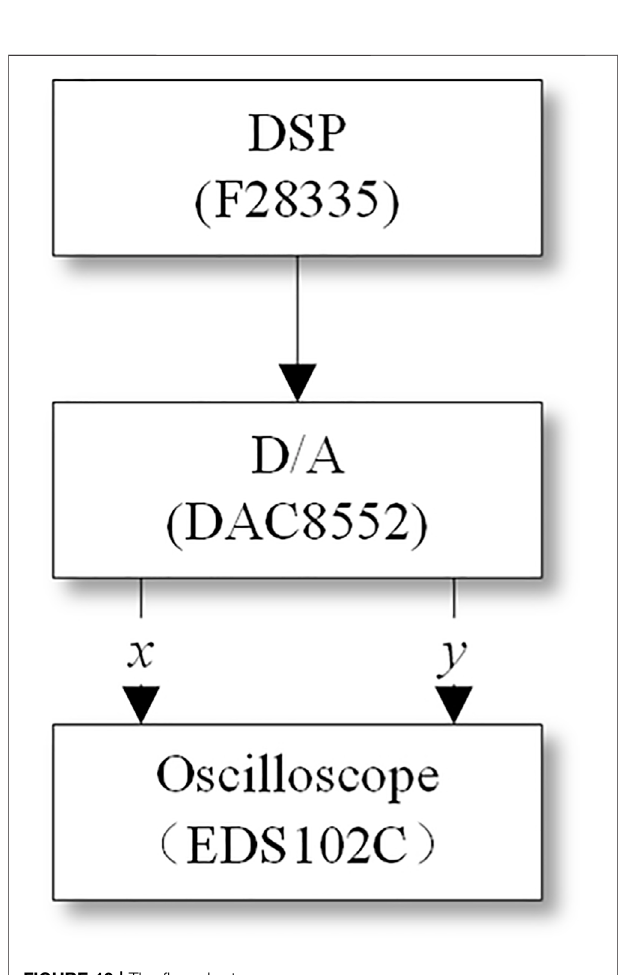
FIGURE 10 | The fl ow